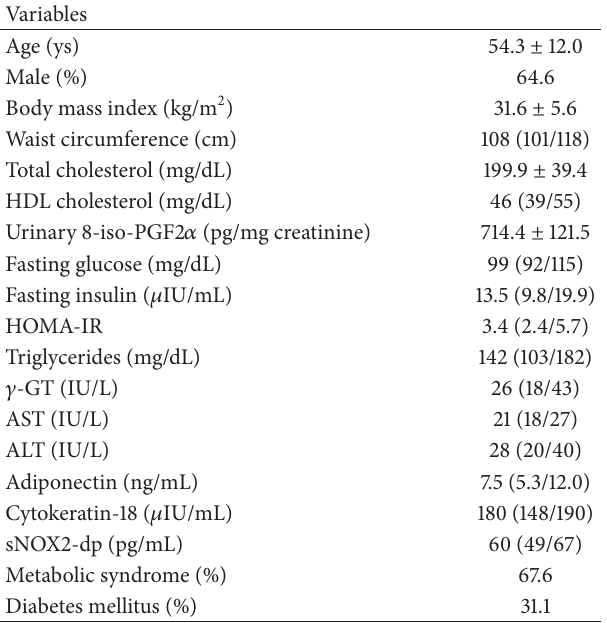
Table 1: Clinical and biochemical characteristics of 209 subjects with